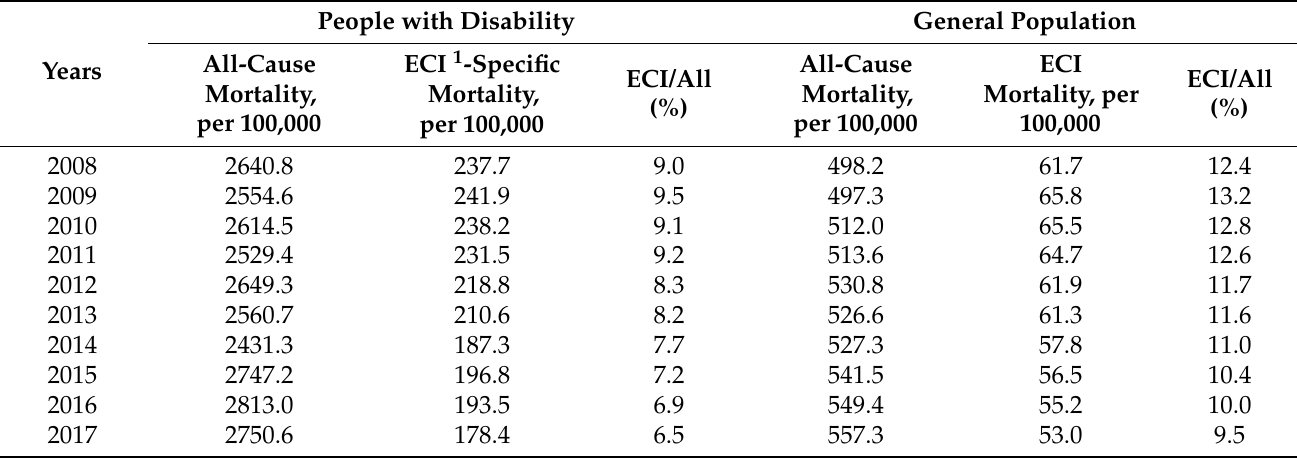
of the general population. The ECI-specific crude mortality rate of people with disabilities ranged from 6.5% to 9.2% in 10 years, whereas that of the general population was from 9.5% to 12.8%. People with disabilities had lower ECI-specific crude mortality rates than the general population, and the rate of ECI-related deaths among people with disabilities and the general population showed a decreasing trend (Table 1). The crude ECI-specific mortality rate of people with disabilities decreased from 237.7 per 100,000 population to 178.4 per 100,000 between 2008 and 2017, representing a decrease of 24.9% over the course of 10 years. The crude ECI-specific mortality rate of the general population decreased from 61.7 per 100,000 in 2008 to 53.0 per 100,000 in 2017, representing a decrease of 14.1% over the 10-year period. Table 1. Crude all-cause mortality rates and crude mortality rates due to external causes of injury (ECIs), 2008–2017. People with Disability General Population All-Cause All-Cause ECI ECI 1 -Specific Years ECI/All ECI/All Mortality, Mortality, Mortality, per Mortality, (%) per 100,000 per 100,000 100,000 per 100,000